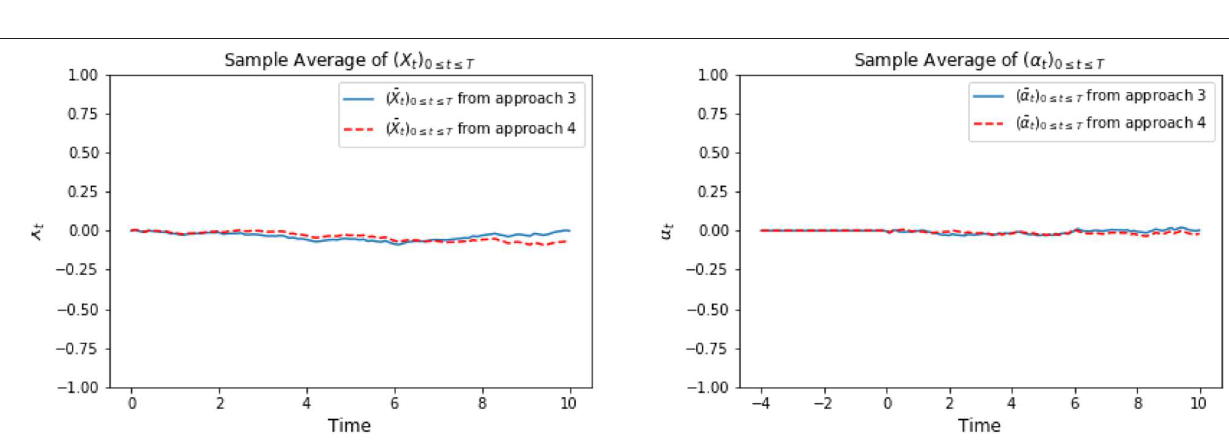
FIGURE 4 | On the left, we compare the sample mean of optimal trajectories of ( X t of optimal control ( α t ) t between approach 3 and approach 4. i 0 ≤ t i ≤ t N